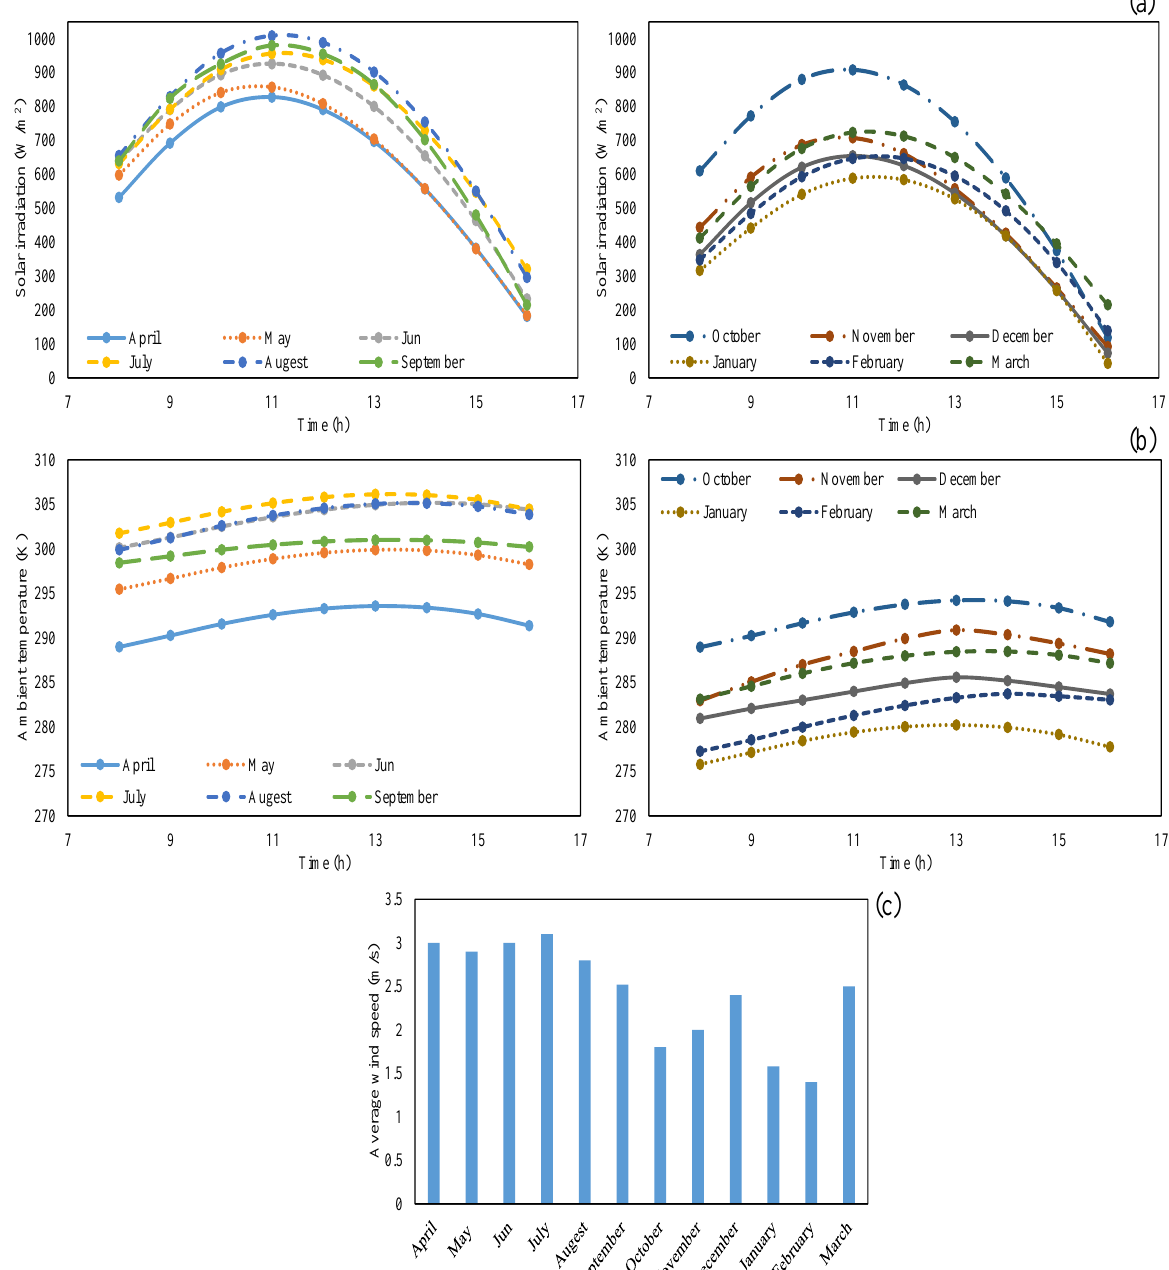
Fig. 5. Average hourly variations of (a) solar irradiation, (b) ambient temperature in a whole year in Mashhad, and (c) average wind speed for each month